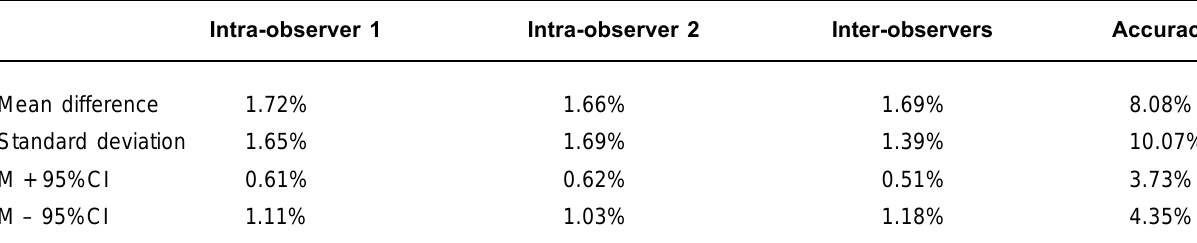
TABLE 2 - Statistical analysis of measurements in maxillary sinus with lesion